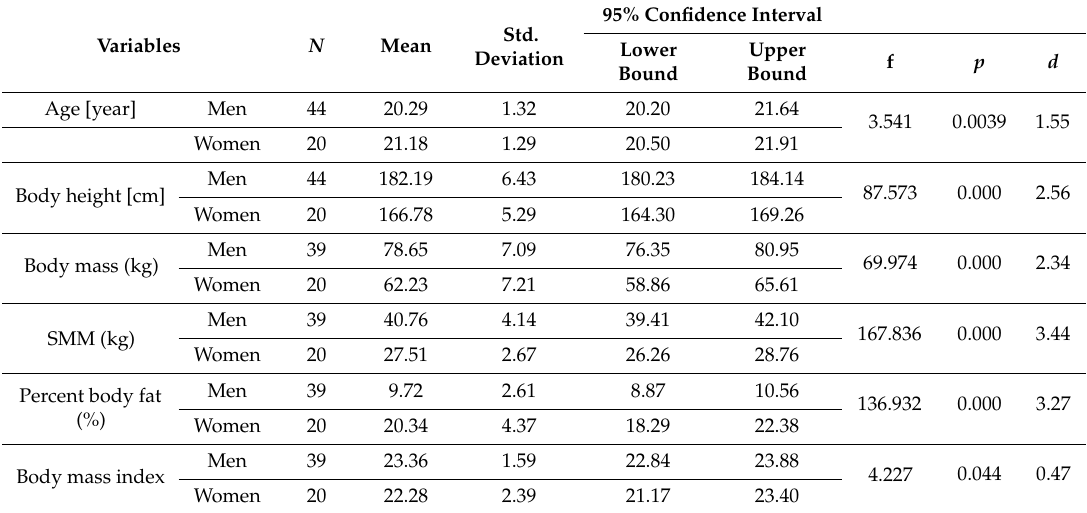
Table 1. Descriptive statistics of selected anthropometric characteristics of female and male athletes.